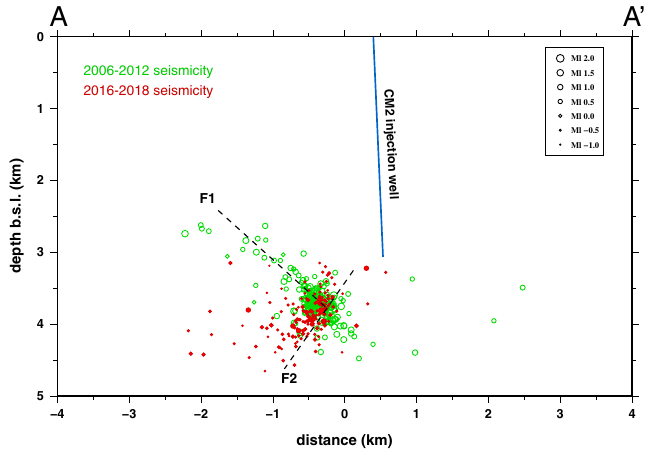
Figure 6. Projection of microearthquake hypocenters of the 2006–2012 seismicity (green circles) and the 2016–2018 seismicity relocated with double-difference method (red circles) along the vertical cross section of the AA ′ profile displayed on the map of Fig. 1. The dimension of circles is proportional to the local magnitude of the seismic events. The blue line represents the projection of the CM2 injection well along the AA ′ vertical cross section. Dashed lines represent the projection along the AA ′ vertical cross section of the NW-trending, NE-dipping back-thrust reactivated by fluid injection operations (F1) and the SW-dipping thrust (F2) acting as hydraulic connection between the injection well and the F1